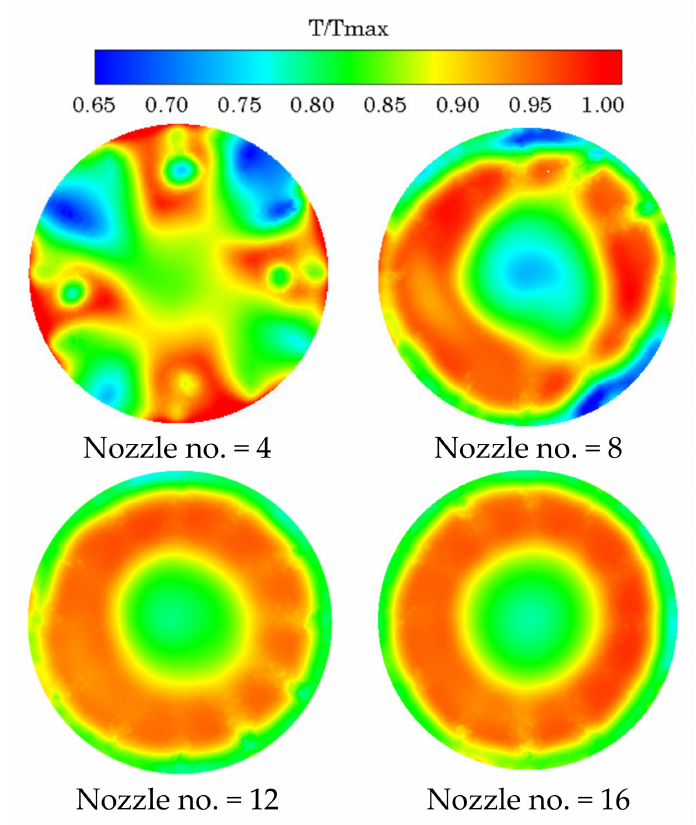
Figure 9. Temperature distribution for different fuel nozzle orifice numbers.